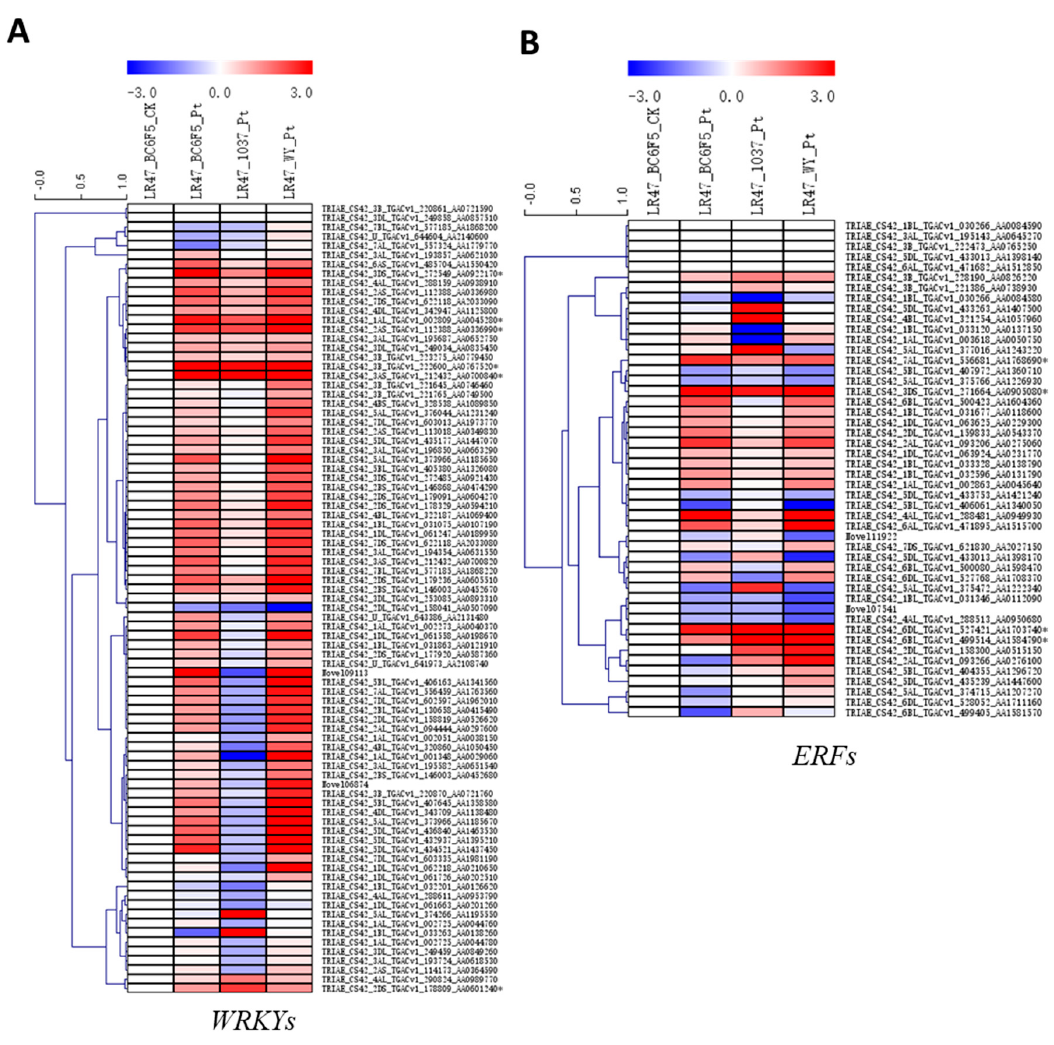
Figure 6. The expression profiles of the genes encoding ( A ) WRKY and ( B ) ERF transcription factors during the Lr47 -mediated resistance. FPKM values for each of the genes in “LR47_BC6F5_Pt”, “LR47_1037_Pt”, and “LR47_WY_Pt” were relative to that in “LR47_BC6F5_CK”. A log2foldchange